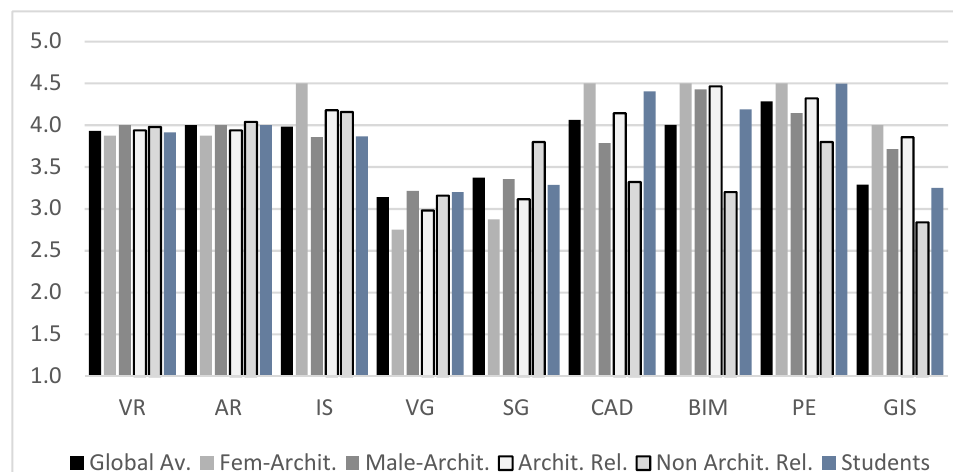
Figure 13. User motivation in future training.